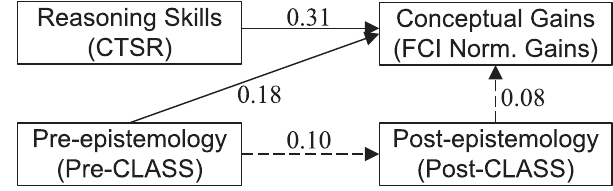
FIG. 2. A resultant model with standardized path coefficients. Dashed arrows indicate insignificant causal